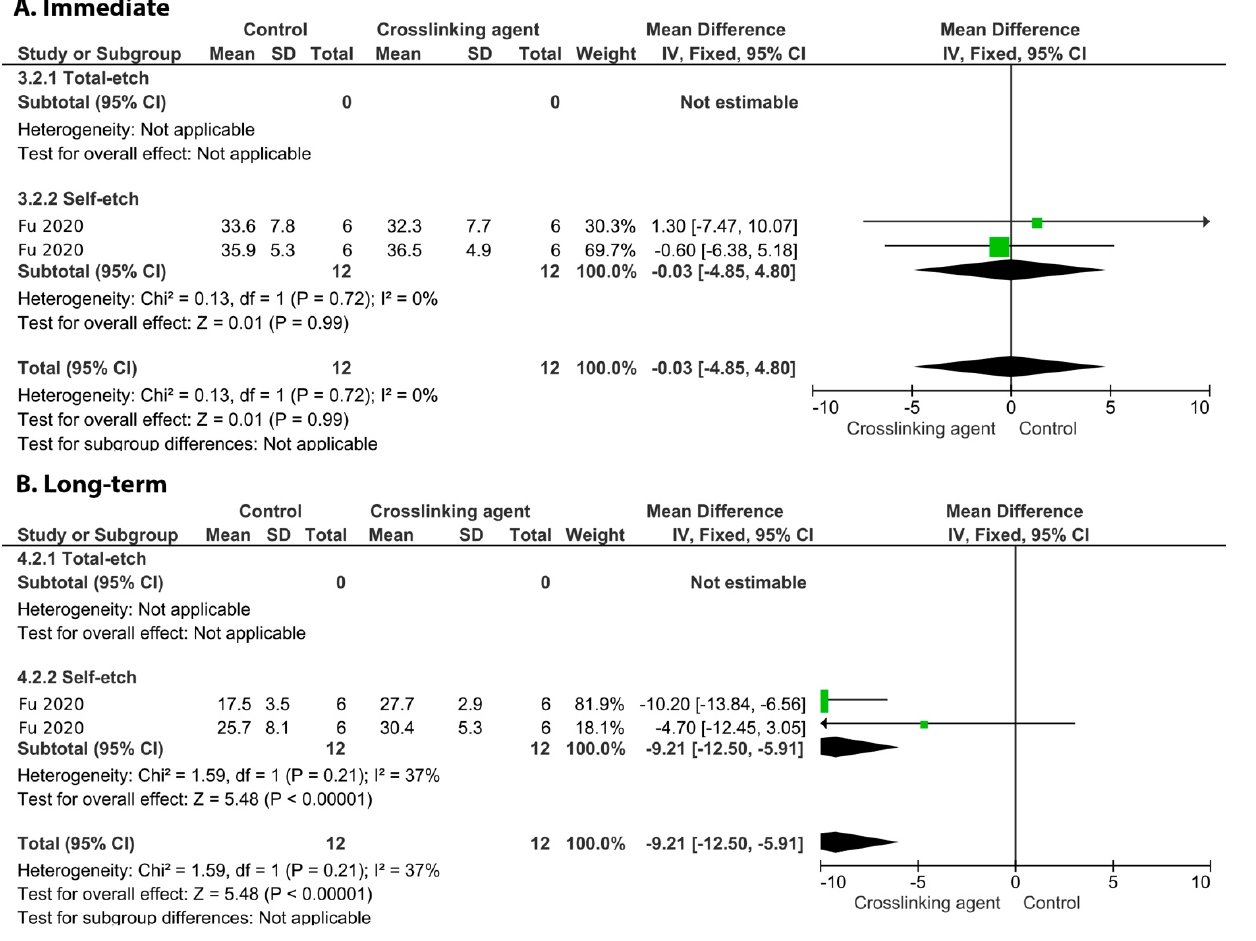
Figure 11. Forest plot of the immediate ( A ) and long-term ( B ) bond strength comparison between the riboflavin crosslinking agent and the control according to the adhesive used, [124].